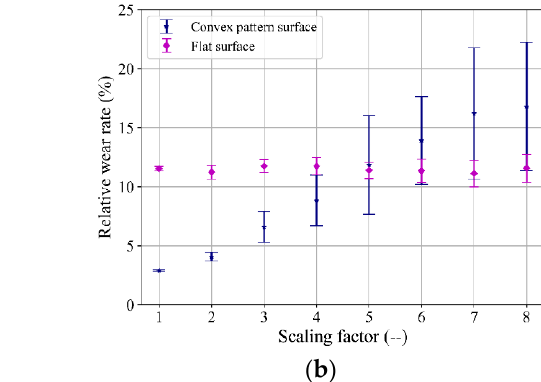
Figure 15. Comparison of the relative velocity and wear rate. ( a ) Relative velocity; ( b ) Relative wear rate.